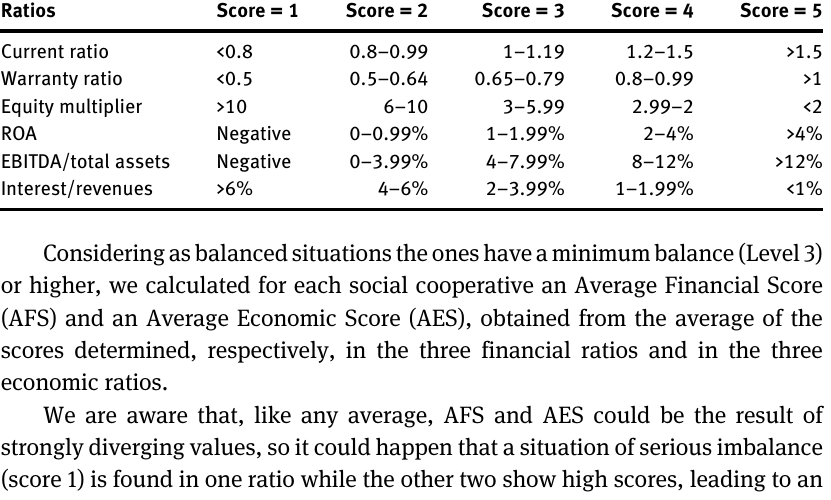
Table  : Ranges of values for the assignment of scores.